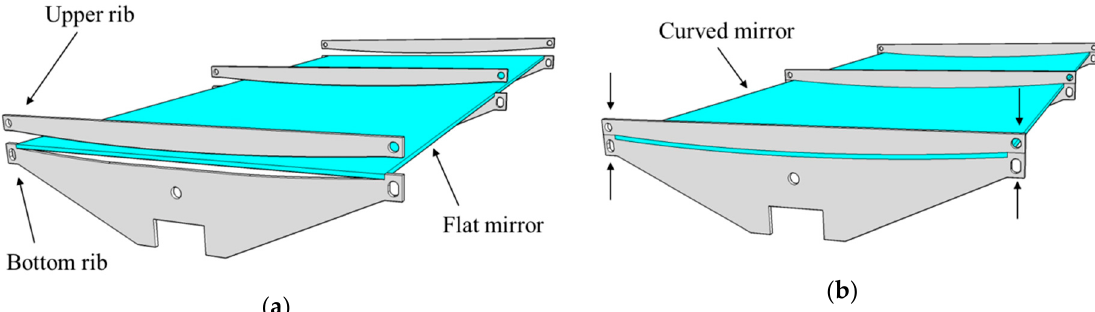
Figure 4. Scheme of the assembly for naked mirror over shaped ribs: ( a ) mirror before ribs clamping and ( b ) mirror after ribs clamping.